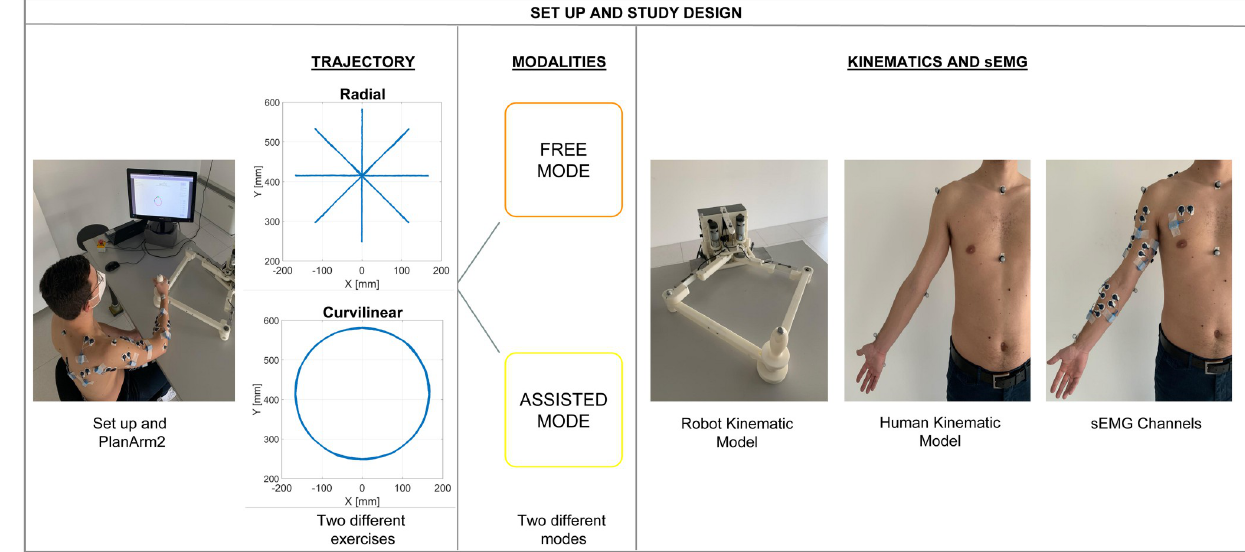
Fig 1. Study design. The left side of the scheme describes the experimental protocol, that included: 2 exercises with point-to-point movements (Radial) and curvilinear movements (Curvilinear), carried out in 2 different modes (Free and Assisted) repeated each one 10 times (total of 40 repetitions). The right panel shows the kinematic experimental models and considered signals. The aim of the work is to investigate muscle synergies of the upper-limb in a context of human-interaction to characterize the effects of robot assistance. Tracking data was elaborated with the Vicon system and EMG with a 16 channel wireless